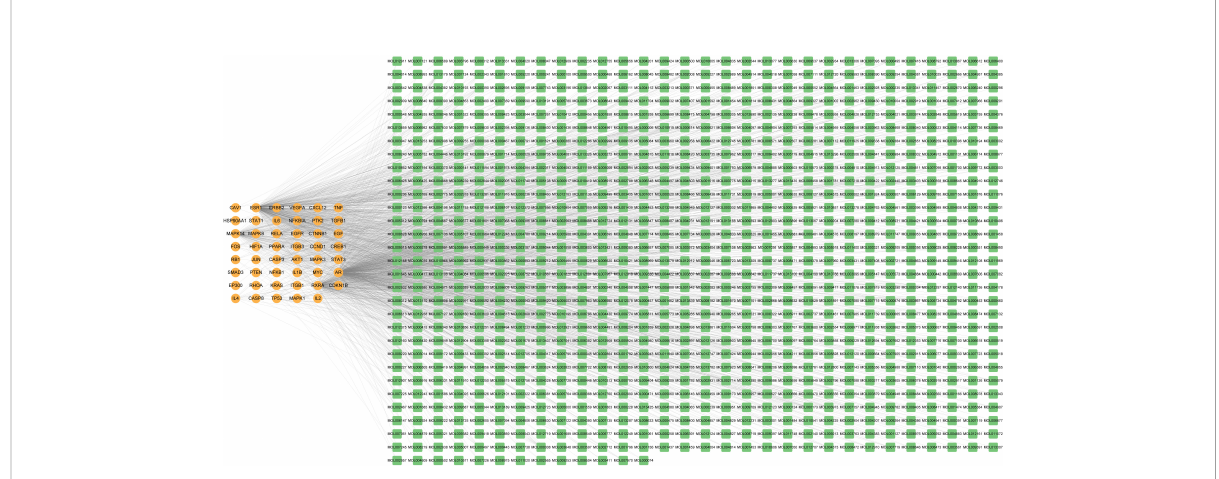
chemical components. Blue nodes in Figure 4 represented mapped 469 herbs.